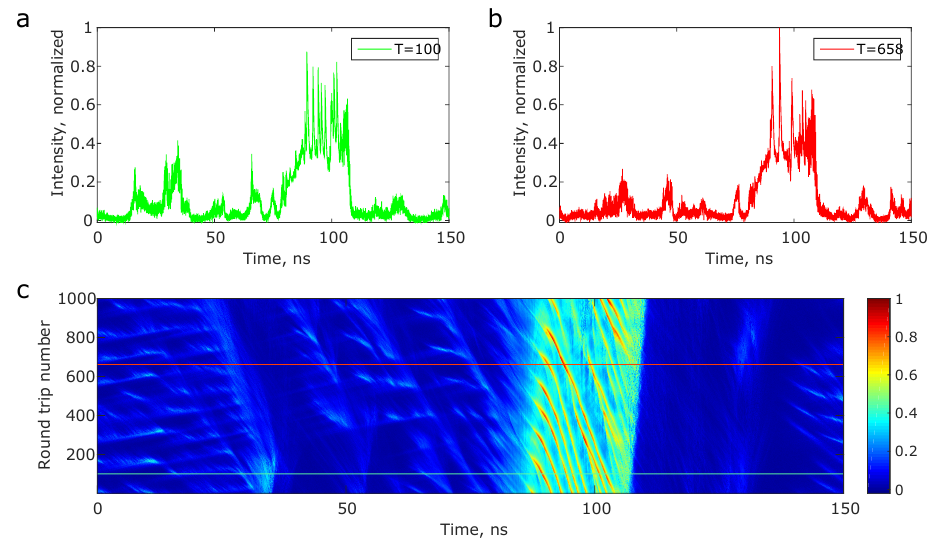
Figure 5. Spatio-temporal dynamics of a partially mode locked fibre laser regime—( a , b ) Typical intensity dynamics observed at different time instants; and ( c ) the spatio-temporal dynamics of the operational regime.